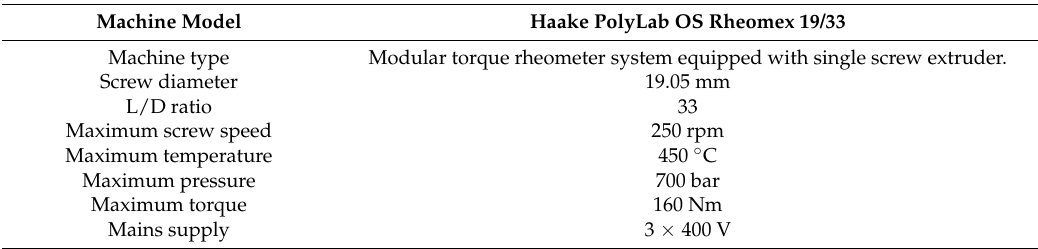
Table 1. Extruder